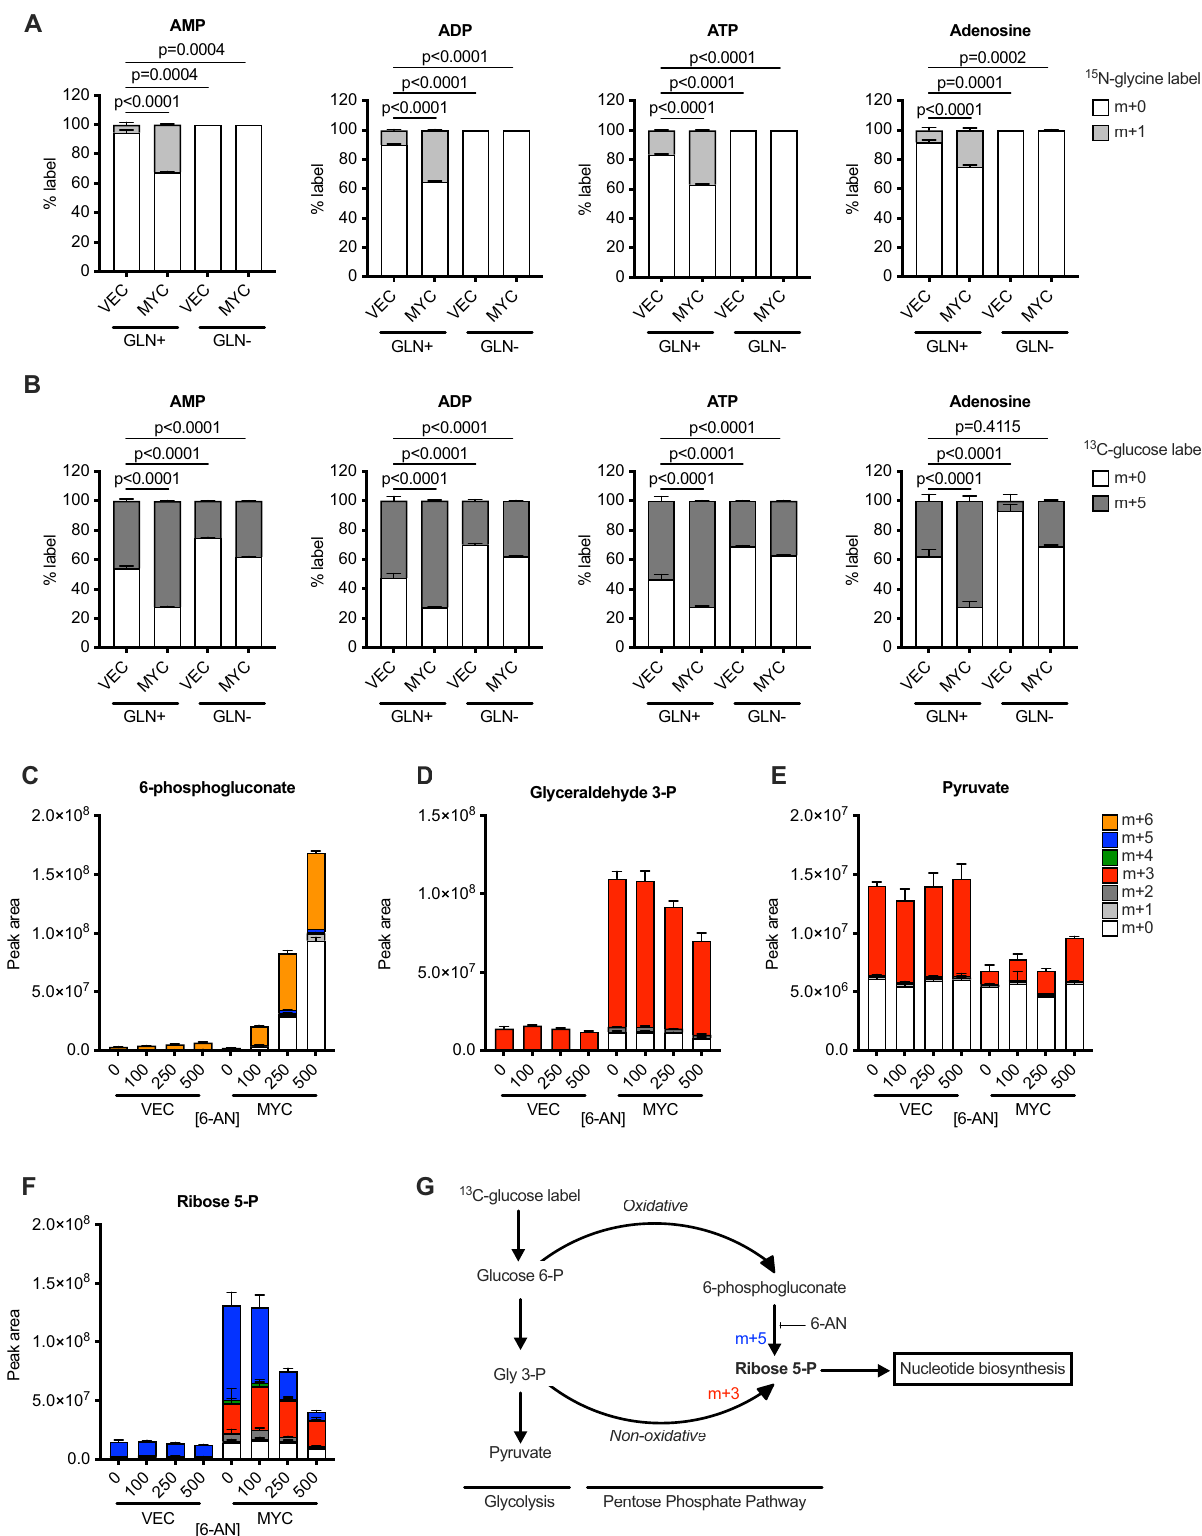
Fig. 2 | MYC drives nucleotide production through the salvage pathway in the absence of glutamine and causes reversal of the non-oxidative pentose phos- phate pathway. A , B MRC-5 cells expressing MYC-ER T2 (MYC) or vector control (VEC) were labelled with ( A ) 15 N-glycine for 12h or ( B ) 13 C 6 -glucose for 6h and the indicated metabolites and isotopologues were measured by LC-MS. An ordinary one-way ANOVA was used to determine statistical signi fi cance ( n =6 biological